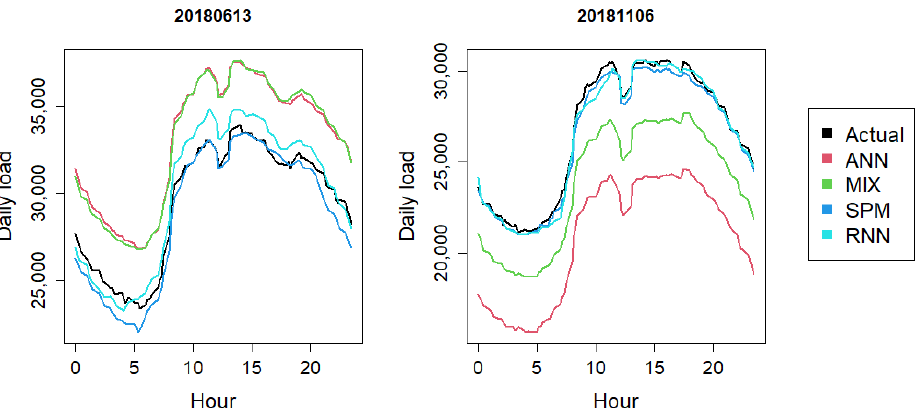
Figure 9. Actual Load and ( D + 1)-day Forecasts for 13 June and 16 November 2018 by the ANN, Mixed, SPM and RNN Models Made on the Previous D Mixed, SPM and RNN Models Made on the Previous D -day.